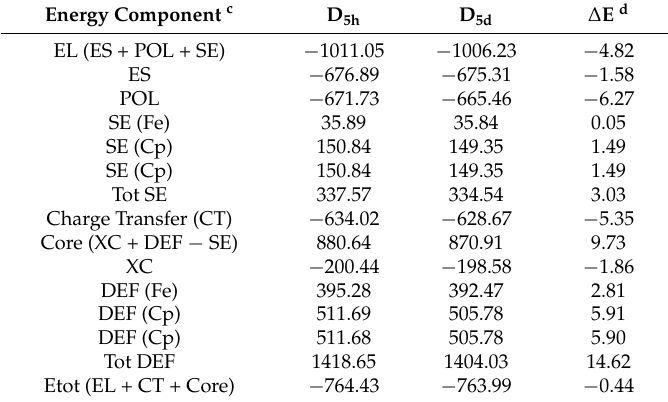
Energy decomposition of ferrocene conformational differences using NEDA scheme (kcal ¨ mol ´ 1 ) a,b